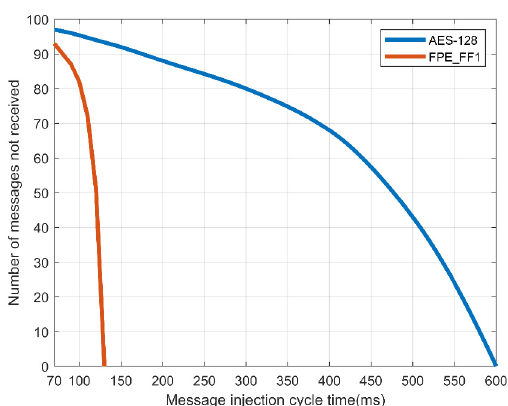
Figure 10. Loss rate of message reception by number of controller area network (CAN) messages in a normal message period.